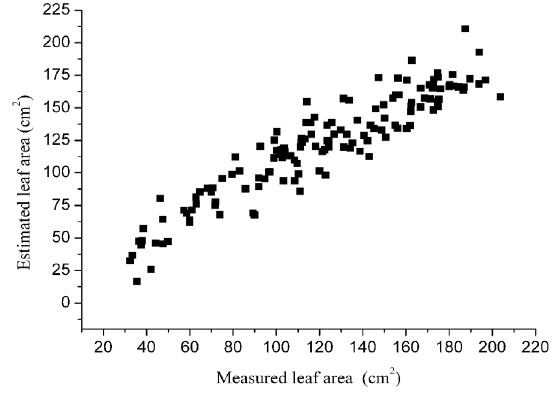
Figure 4 - Dispersion of data between the measured leaf area (cm 2 ) and the estimated leaf area (cm 2 ) using the function LA = -69.9188 + 15.5102L + 0.0197726K - 0.0768998J in cassava leaves, cultivar IAC 576-70, at 80 days after planting in the region of Botucatu, SP, Brazil. (LA = leaf area; L = lobe length; K = lobe length x lobe width; J = lobe length x number of lobes).